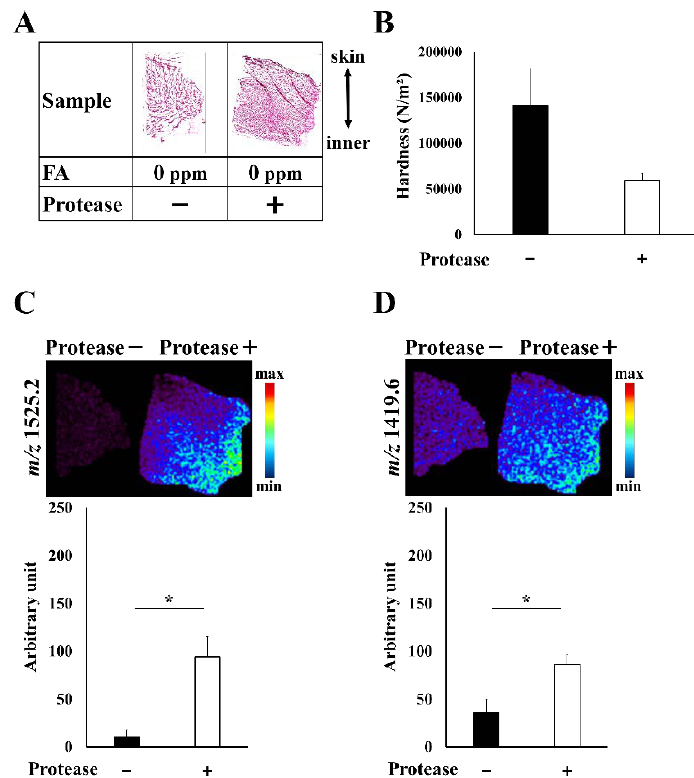
Figure 3. ( A ) Sample conditions—samples treated with and without protease. ( B ) The hardness value was reduced after treatment with protease. ( C and D ) MS imaging results in m / z 1525.2 and m / z 1419.6 between two di ff erent fish fillet samples. *: Di ff erences with p < 0.05 were considered statistically significant.